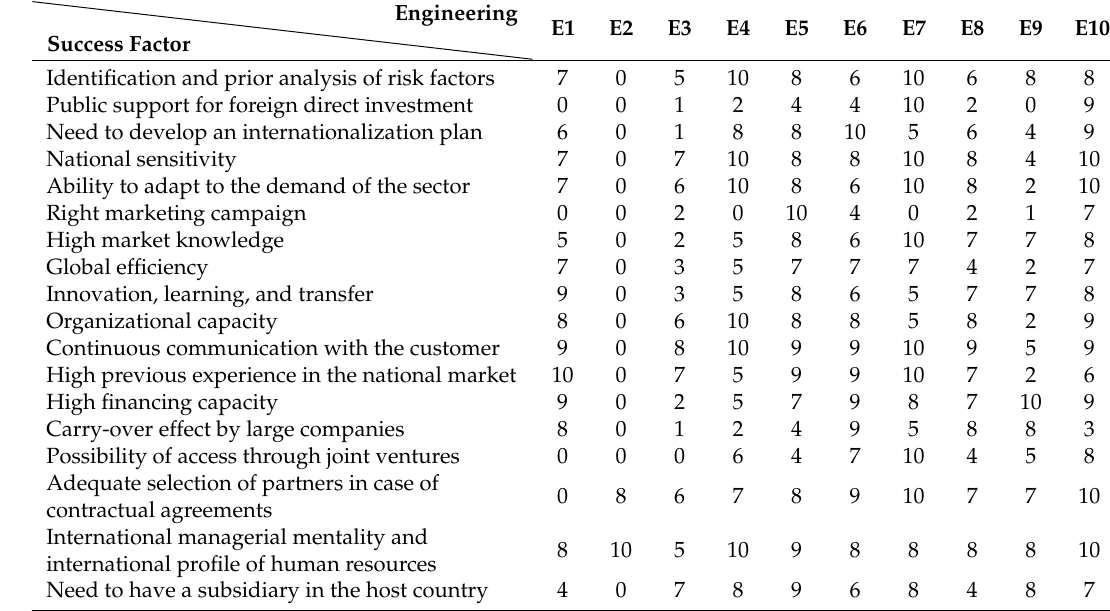
Table 8. Degree of agreement/disagreement of the companies interviewed regarding the success